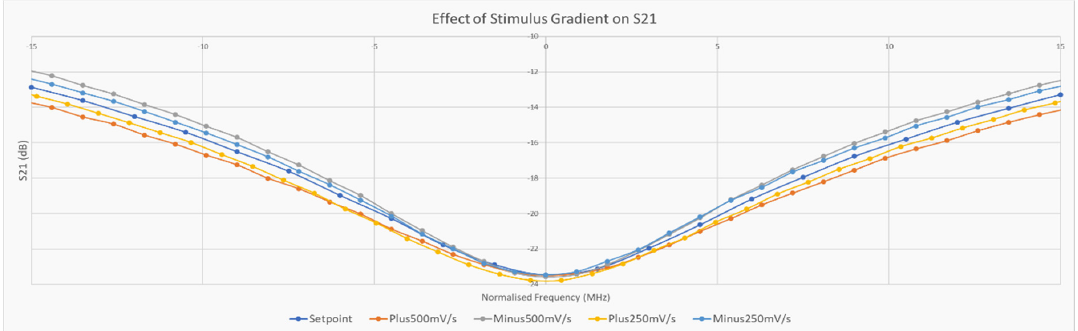
Figure 11. Stimulus gradient results.